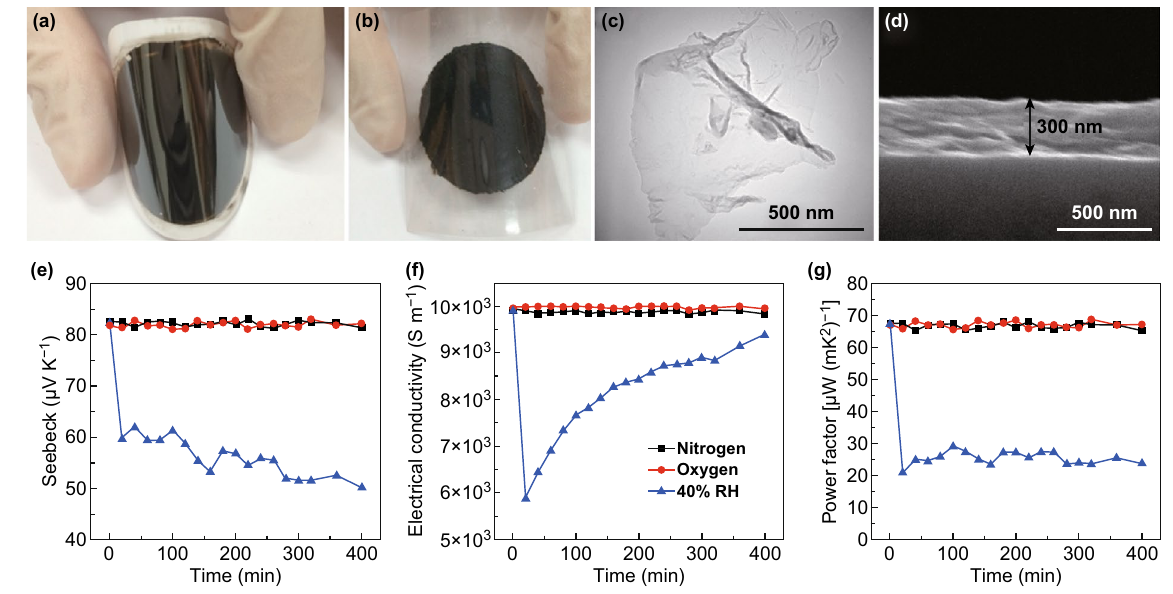
Fig. 7 MoS 2 nanosheets restacked film a on a cellulose ester membrane and b on a PET substrate. c TEM image of a single exfoliated MoS 2 nanosheet and d cross-sectional SEM image of the MoS 2 nanosheets restacked film. e Dynamic Seebeck coefficient, f electrical conductivity, and g power factor of the MoS 2 nanosheets restacked film in a nitrogen, oxygen and 40% relative humidity atmosphere. Reproduced with permission from Ref. [181]. Copyright 2016,